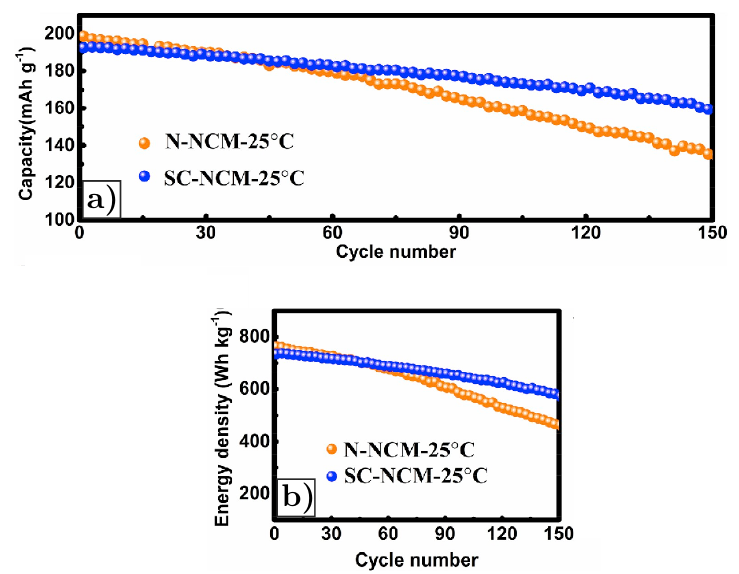
Figure 26. ( a ) Comparison of capacity and ( b ) Energy density decay between single-crystalline (SC-NCM) and commercial polycrystalline (N-NCM) NMC831106 cycled at 1C in the voltage range of 2.75–4.4 V over 150 cycles. Reprinted with permission of [123], ©2020